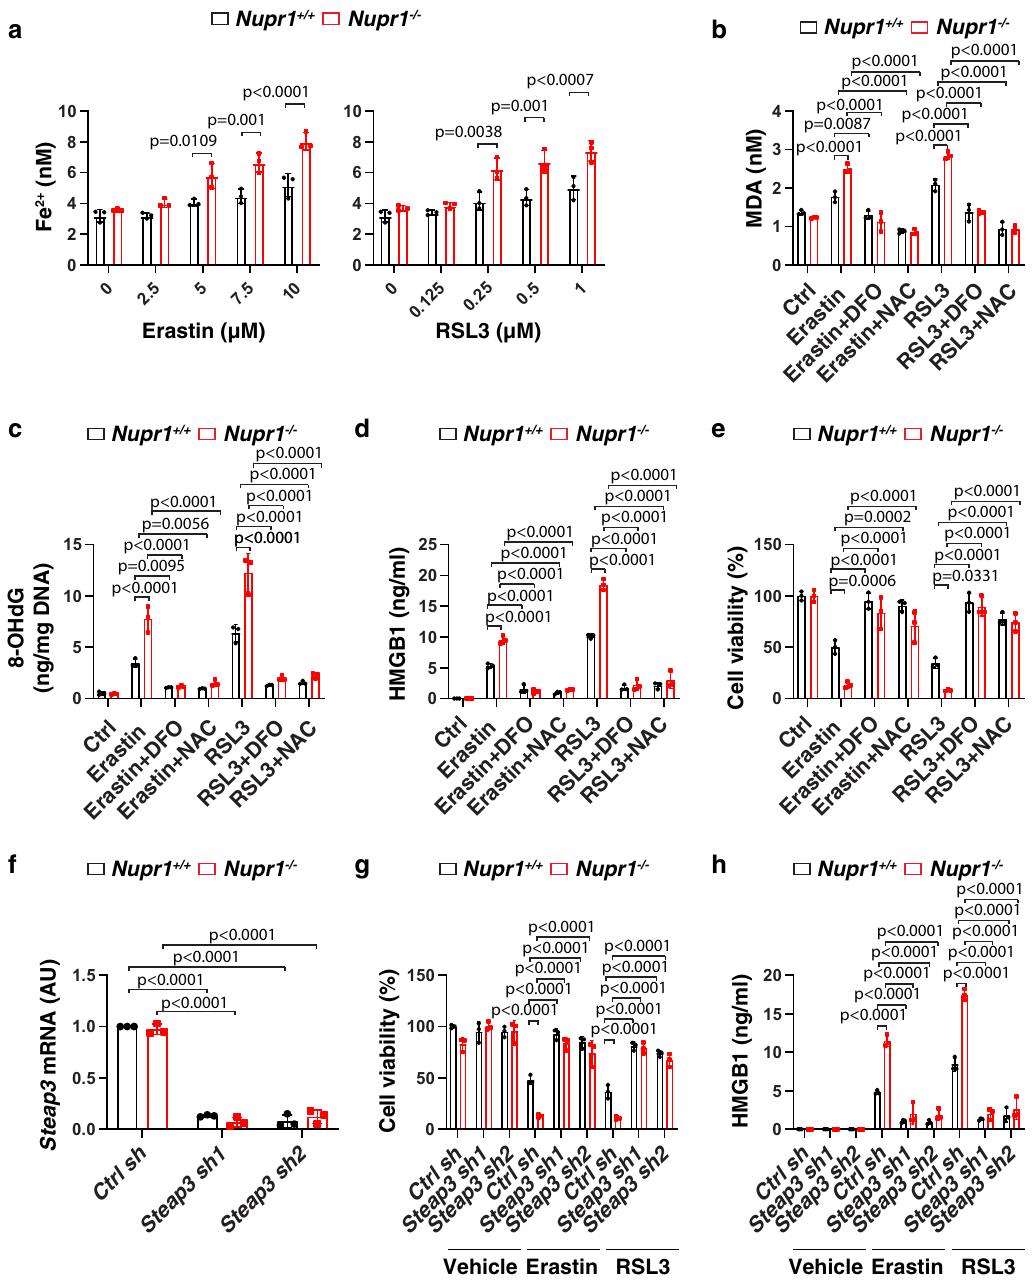
Fig. 2 NUPR1 inhibits iron-dependent oxidative damage in ferroptosis. a Fe 2 + levels in indicated mPDAC cells following treatment with erastin or RSL3 for 24 h ( n = 3 well/group, two-way ANOVA with Tukey ’ s multiple comparisons test on all pairwise combinations). b – e Indicated mPDAC cells were treated with erastin (10 µ M) or RSL3 (1 µ M) in the absence or presence of DFO (100 µ M) or NAC (1 mM) for 24 h, and then intracellular MDA ( b ), intracellular 8-OHdG ( c ), extracellular HMGB1 ( d ), and cell viability ( e ) were assayed ( n = 3 well/group, two-way ANOVA with Tukey ’ s multiple comparisons test on all pairwise combinations). f qPCR analysis of Steap3 mRNA in indicated mPDAC cells ( n = 3 well/group, two-way ANOVA with Tukey ’ s multiple comparisons test on all pairwise combinations). g , h Indicated mPDAC cells were treated with erastin (10 µ M) or RSL3 (1 µ M) or vehicle (0.01% dimethyl sulfoxide) for 24 h, and then extracellular HMGB1 ( g ) and cell viability ( h ) were determined ( n = 3 well/group, two-way ANOVA with Tukey ’ s multiple comparisons test on all pairwise combinations). Data in a – h are presented as mean ± SD. The results in a – h are representative of those from 2 to 3 independent experiments with three technical replicates (Supplementary Fig. 4) cells following treatment with erastin or RSL3, which was reversed by DFO or the ferroptosis inhibitor liproxstatin-1. These fi ndings indicate that LCN2 plays a similar role as NUPR1 in the inhibition of ferroptosis. To determine whether the downregulation of LCN2 is essential for the induction of ferroptosis, we re-expressed Lcn2 in Nupr1 − / −